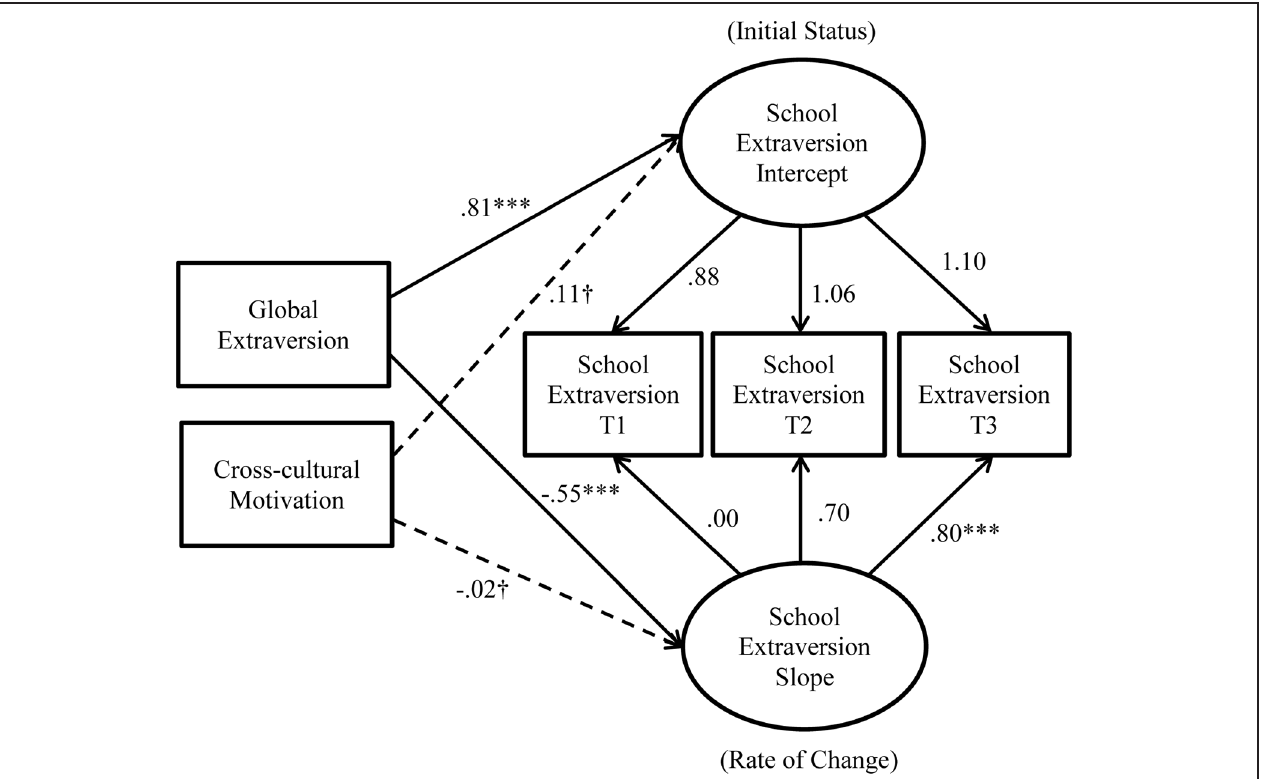
FIGURE 4 | Results from the modified Model 2 with the predictors and school extraversion change. ∗ p < 0.05; ∗∗ p < 0.01; ∗∗∗ p < 0.001; † p ≥ 0.05; N = 215. Estimates are standardized estimates from the modified Model 2 (i.e., the unconstrained model). Solid lines represent significant paths, whereas dotted lines represent insignificant